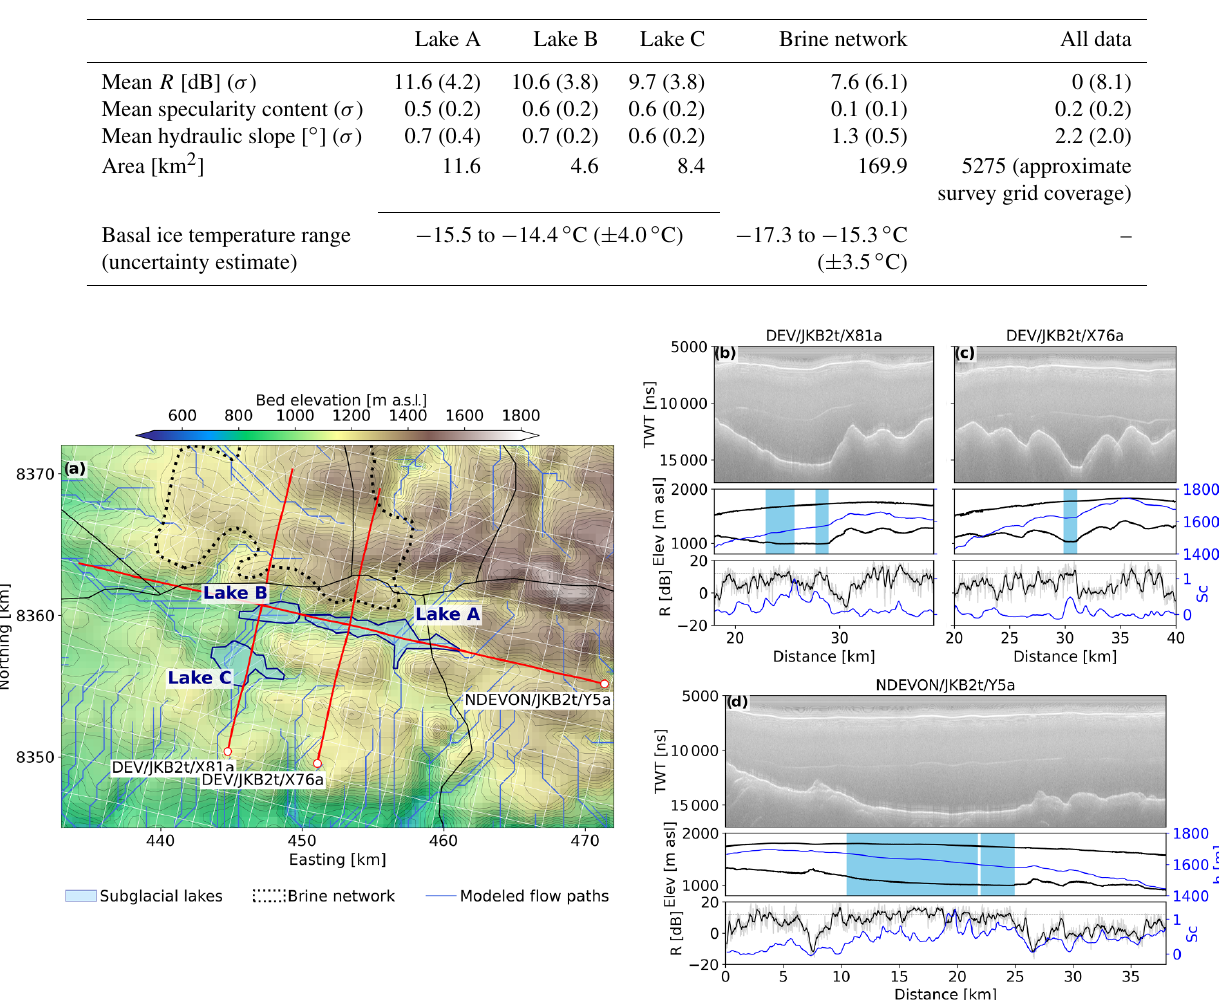
Table 1. Radiometric characteristics, subglacial hydraulic slope, and areal extent of the subglacial lakes and brine network, compared to the entire dataset. R is the basal reflectivity normalized to the mean of all measured basal reflectivity values. The values in parentheses represent the standard deviation ( σ ) of the corresponding parameter. Additionally, basal ice temperatures were derived from a 1-D steady- state advection–diffusion model (Cuffey and Paterson, 2010) with the same parameters as described in Rutishauser et al. (2018) (see Fig. S7 for basal ice temperature map).